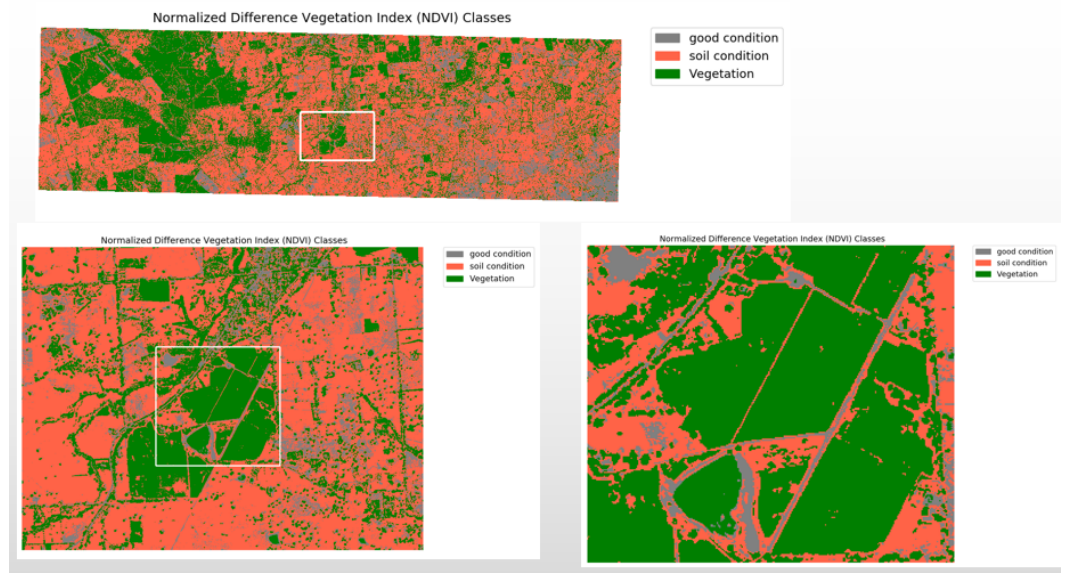
Figure 11. Road surface condition detection and classification results for GeoEye’s OrbView–3 satellite dataset by zooming in on white boxes.